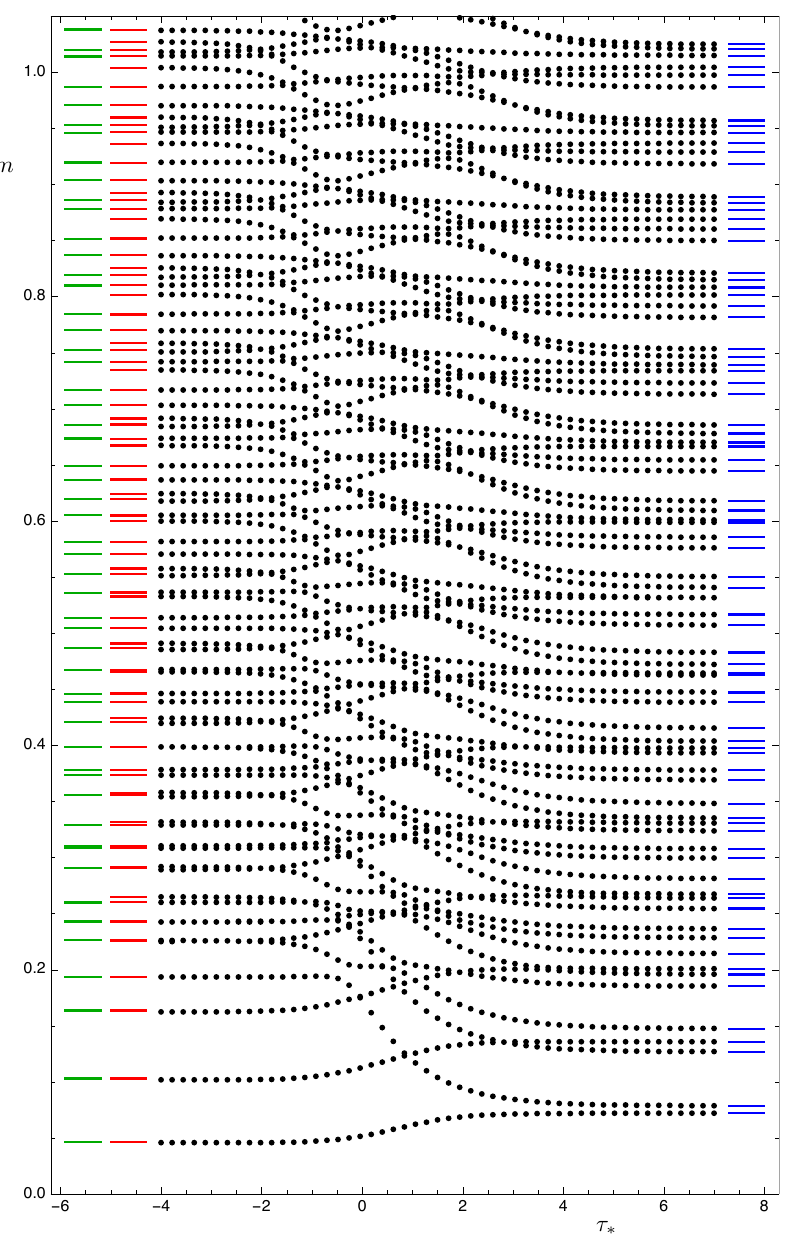
Figure 6 . Mass spectrum m of spin-0 states as a function of (cid:28) (cid:12)gure 4. Also shown is the spin-0 spectrum of B OP six scalars) and B conf (blue, right). 8